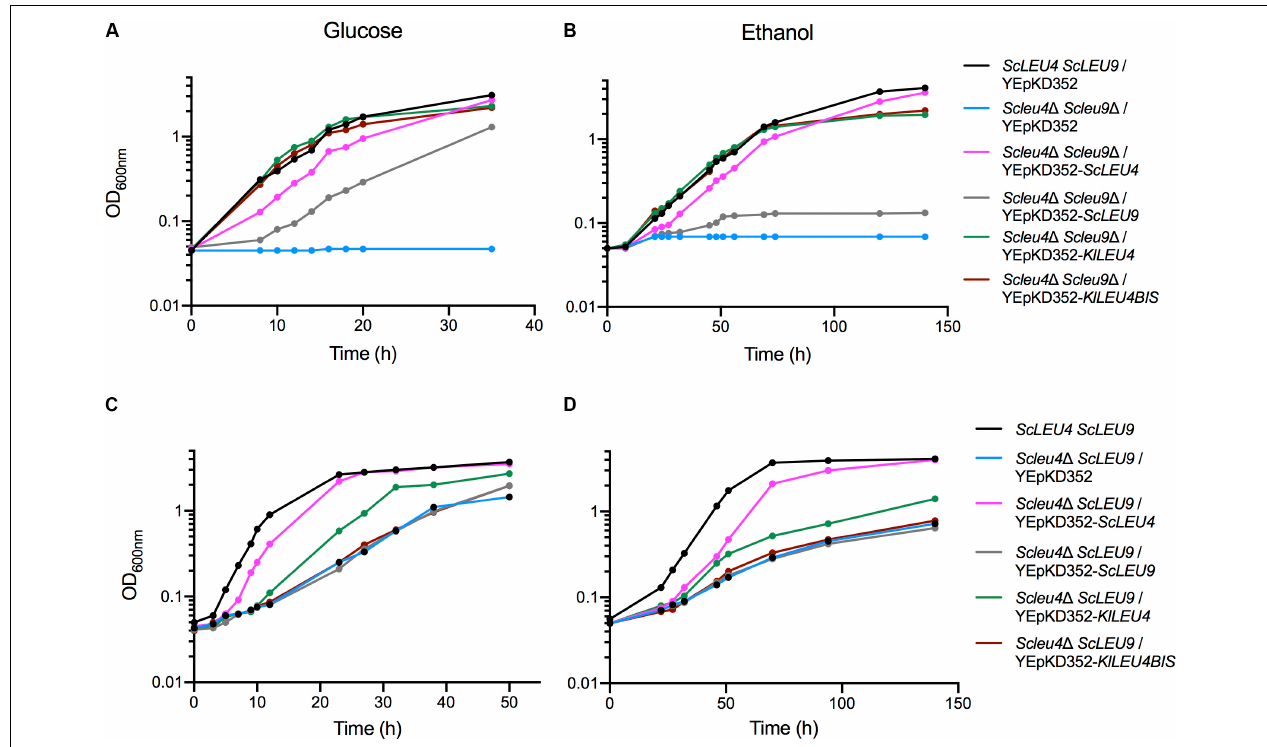
FIGURE 7 | KlLEU4 and KlLEU4BIS S. cerevisiae double and single mutant complementation. Growth curves of S. cerevisiae Scleu4 (cid:49) ScLEU9 harboring plasmids YEpKD352, YEpKD352- ScLEU4 , YEpKD352- ScLEU9, YEpKD352- KlLEU4, or YEpKD352- KlLEU4BIS . Cells were grown on minimal medium with either (A) (2%, w/v) glucose, or (B) (2% v/v) ethanol. Glucose growth curves of S. cerevisiae wild type ScLEU4 ScLEU9 strain and double Scleu4 (cid:49) Scleu9 (cid:49) mutant transformed with YEpKD352- ScLEU4 , YEpKD352- ScLEU9 , YEpKD352- KlLEU4, or YEpKD352- KlLEU4BIS . Strains were grown on minimal medium with (C) (2% w/v) glucose or (D) (2% v/v) ethanol. Experiments were done in